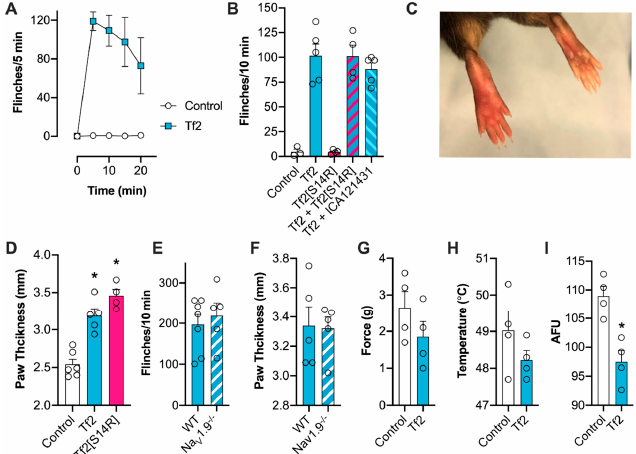
Figure 4. Intraplantar injection of Tf2 causes spontaneous pain behaviors and local swelling in mice ( A ) Time course of spontaneous pain behaviors induced by Tf2 (1 µM i.pl.). ( B ) Intraplantar injection of Tf2 (1 µM) causes spontaneous pain behaviors while intraplantar injection of Tf2[S14R] (10 µM) does not. Co-injection of Tf2[S14R] (10 µM) with Tf2 (1 µM) or ICA-121431 (500 nM) causes no reduction in spontaneous pain behaviors. ( C ) Intraplantar injection of Tf2 (left hind paw) causes local erythema (redness) and swelling. ( D ) Intraplantar injection of both Tf2 (1 µM) and Tf2[S14R] (10 µM) causes a significant increase in paw swelling. ( E ) Tf2-induced spontaneous pain behaviors are not attenuated in Na V 1.9 -/- mice. ( F ) Tf2-induced swelling is not attenuated in Na V 1.9 -/- mice. ( G ) Intraplantar injection of Tf2 (1 µM) has no effect on mechanical thresholds. ( H ) Intraplantar injection of Tf2 (1 µM) has no effect on heat thresholds. ( I ) Intraplantar injection of Tf2 (1 µM) causes a reduction in weight bearing (as measured by arbitrary fluorescence units; AFU). Data are presented as mean ± SEM with individual values plotted ( n = 3–7 mice). Statistical significance was determined using t -test or one-way ANOVA with Dunnett’s post-test as appropriate, * p < 0.05 compared to control or WT.